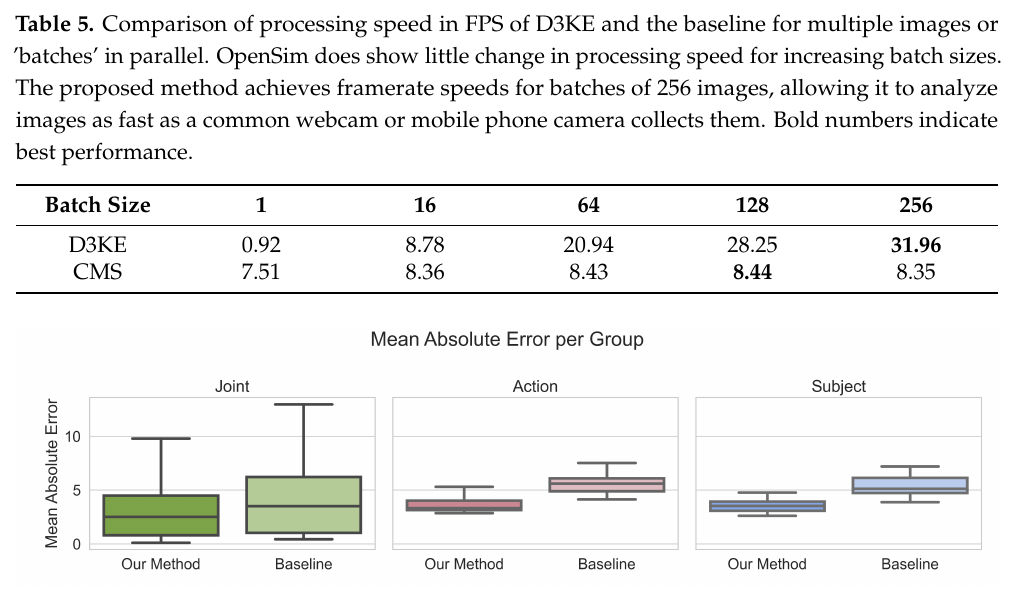
Figure 4. Mean absolute error for predicted joint angles per joint, movement and subset. Across these groups, D3KE shows less variation compared to the CMS. The low variations indicate that D3KE is suitable for use on different participants and movements. Table 6. Median and inter-quartile ranges (IQR) of joint angles per joint , movement and participant . MAE, RMSE and correlation are calculated over individual frames, Medians and IQR are reported due to the skewed distribution of results. Within each group, both camera views show similar errors. Joint angles show the highest error and highest spread of values of all groupings. D3KE generalizes well to different movements, participants and camera